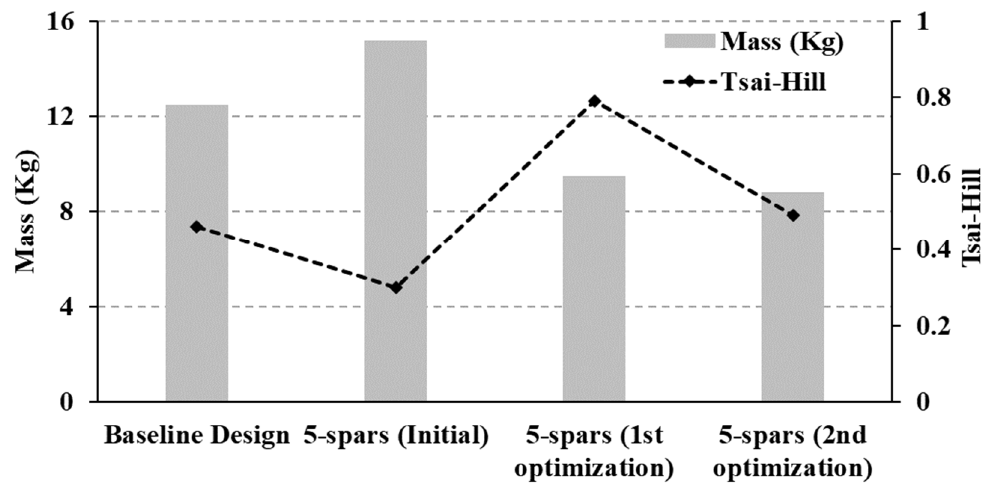
Figure 13. The mass and Tsai–Hill index comparison of the optimized designs of coreless spoiler.